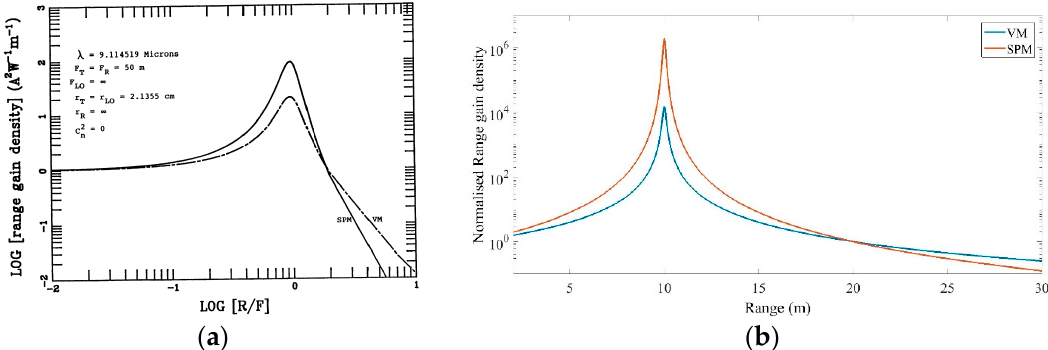
Figure 4. ( a ) “Normalized range gain density” from Kavaya et al. [24], for volume mode and single-particle mode ( λ = 9.11 μ m, beam radius to 1/e 2 intensity points at the lens = 30.2 mm, focus distance = 50 m); ( b ) Same quantities calculated for a ZephIR-type lidar (1.57 µ m, 25 mm, 10 m).